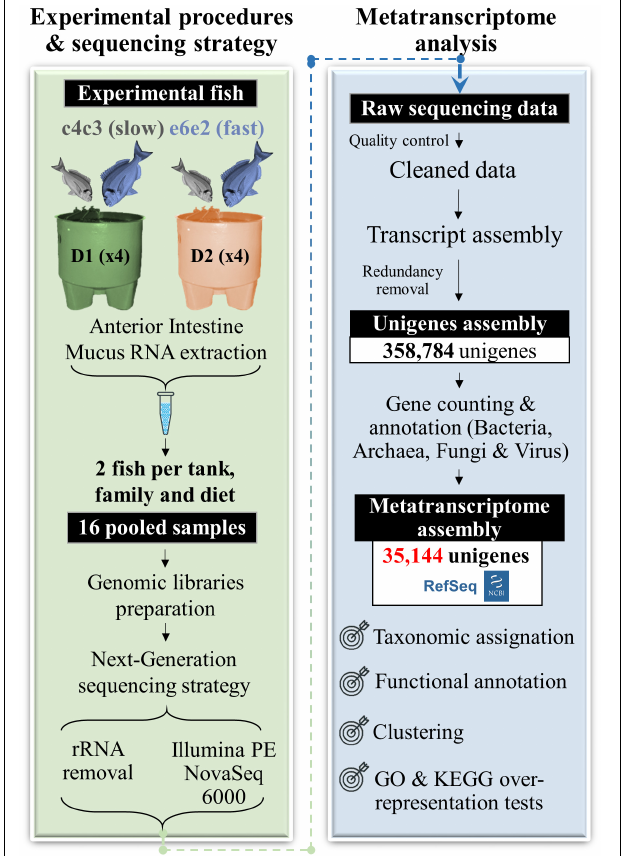
FIGURE 1 | Workflow of the gilthead sea bream metatranscriptome assembly conducted in this study. Black boxes with white text indicate generated genomic resources, according to the following steps: experimental procedures and sequencing, metatranscriptome assembly, and post-assembly analyses (taxonomic assignation, functional annotation, and GO and KEGG over-representation